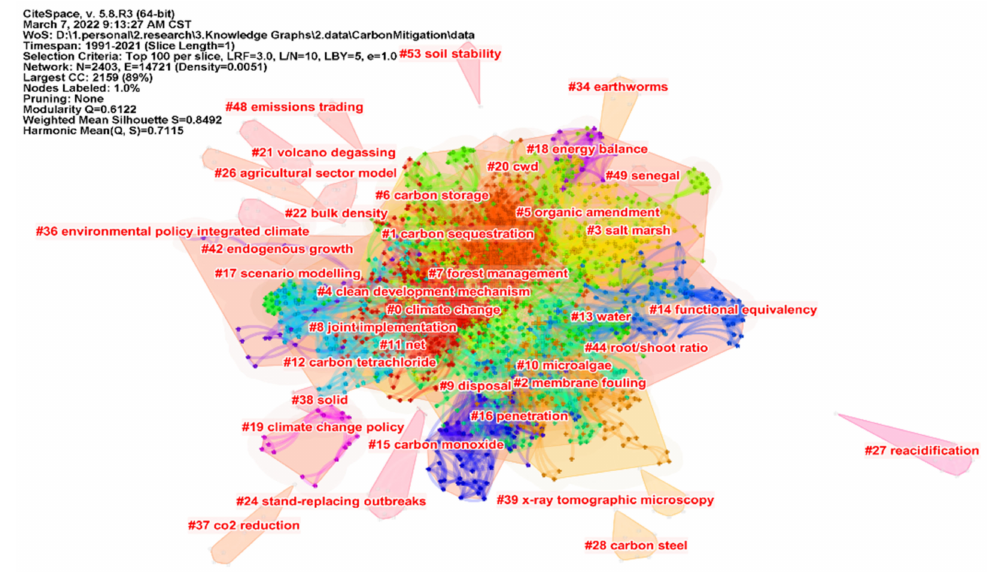
Figure 8. Knowledge Map of Keyword Clustering of Cited Literature in Carbon Emission Reduction Research.